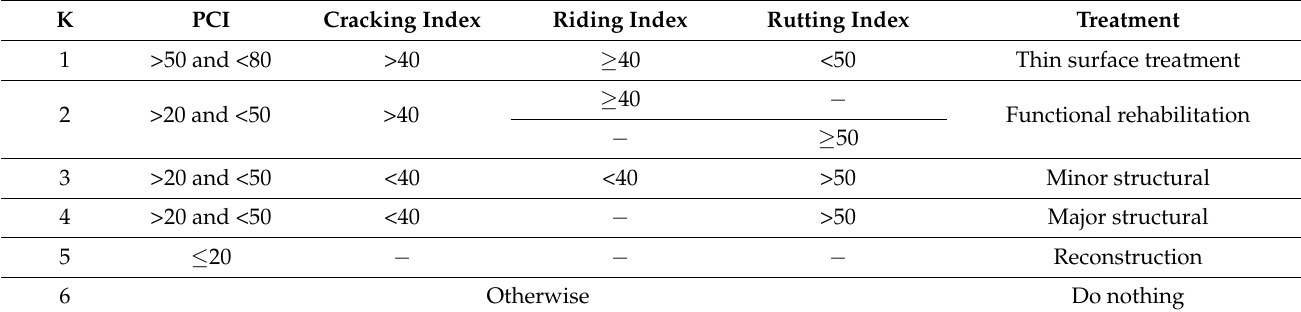
Figure 10. Weighted average PCI for COM pavements versus pavement age. Table 3. Modified Iowa DOT decision matrix for AC and COM